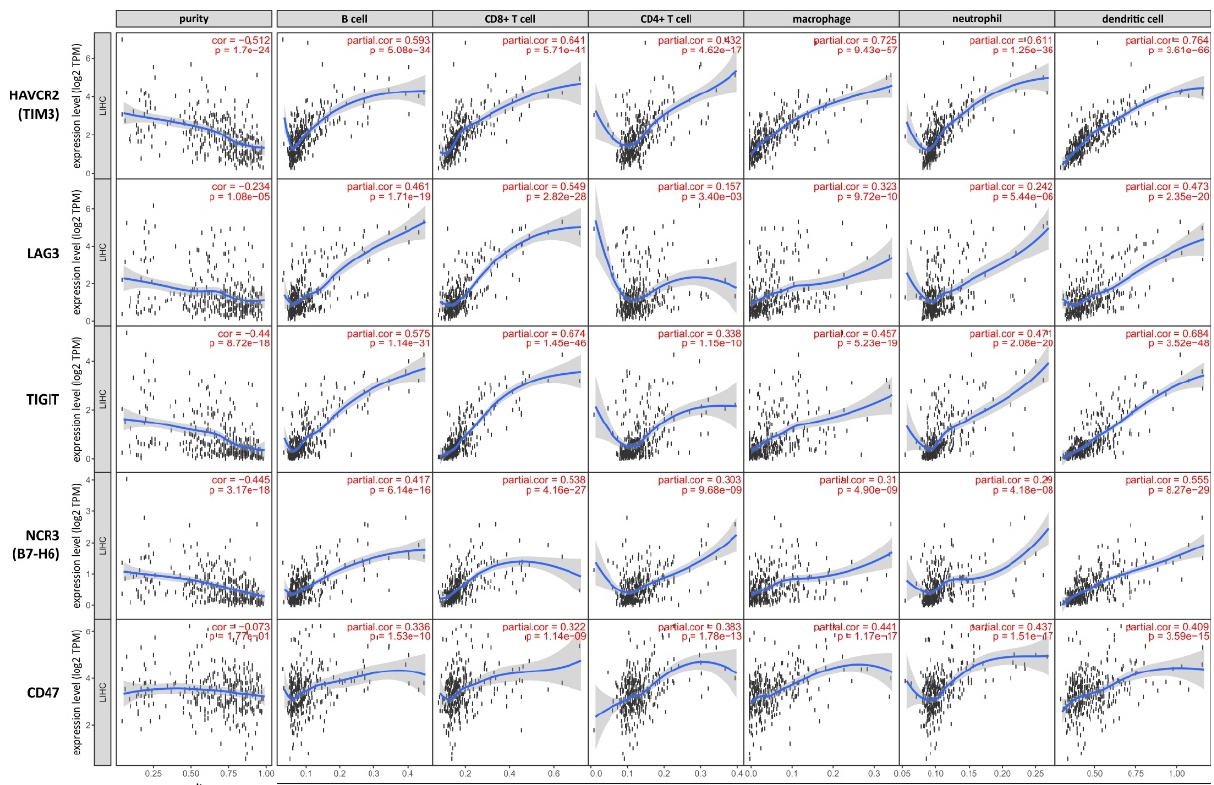
Figure 4. In silico analysis using TIMER with the gene module for markers of immune modulation TIM3, LAG3, TIGIT, B7-H6 and CD47-SIRPa in HCC.